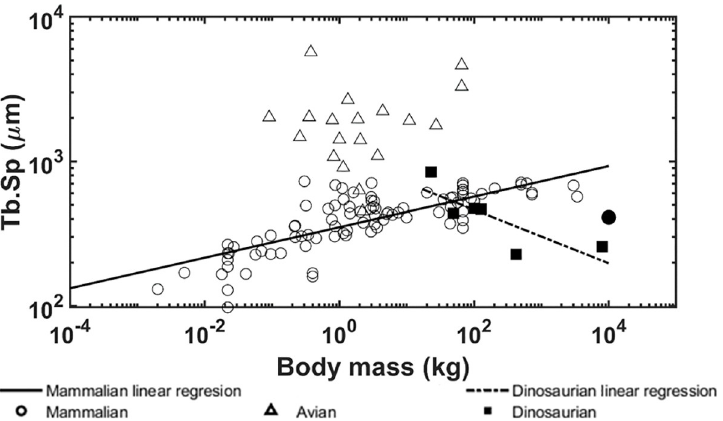
Fig 8. Logarithmically scaled plots of the trabecular spacing (Tb.Sp) versus body mass. Pairwise comparisons indicate the dinosaur regression slope is different from the mammalian (p < 0.001) and avian (p = 0.007) slopes. The solid circle indicates the mammoth.